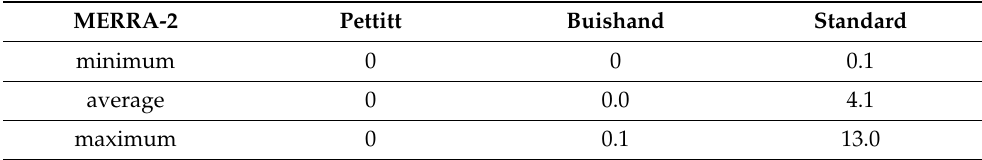
Table 6. Minimal, average and maximal share of explained discontinuities in percentage by the change in 2015 to all discontinuities from all months from MERRA-2 for the Pettitt test, the Buishand test and the Standard Normal Homogeneity test. Here, 0 means mathematical zero, 0.0 nearly zero but not mathematical zero.